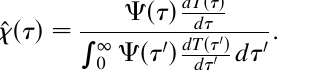
FIG. 3. The logarithm (base e ) of the rate of new infections exponential network with (cid:5) ¼ 4 (right panel), with (cid:1) i ¼ 0 : 127 71 and (cid:1) r ¼ 0 : 25 . Two independent epidemic realizations are shown in each panel (green and blue). The solid red line shows the tangent of ln ½